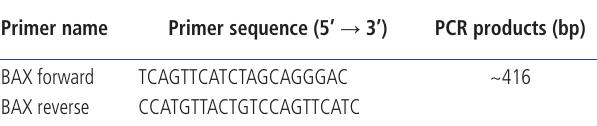
Table 1. Primers used for amplification of the BAX